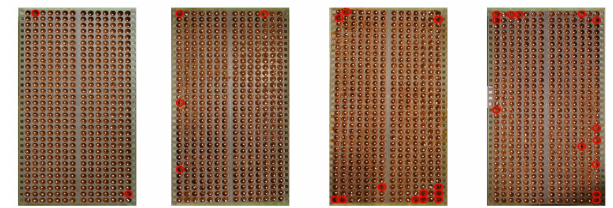
Figure 17. Empty cells of pot tray for each actuator operating time and conveyor belt speed.